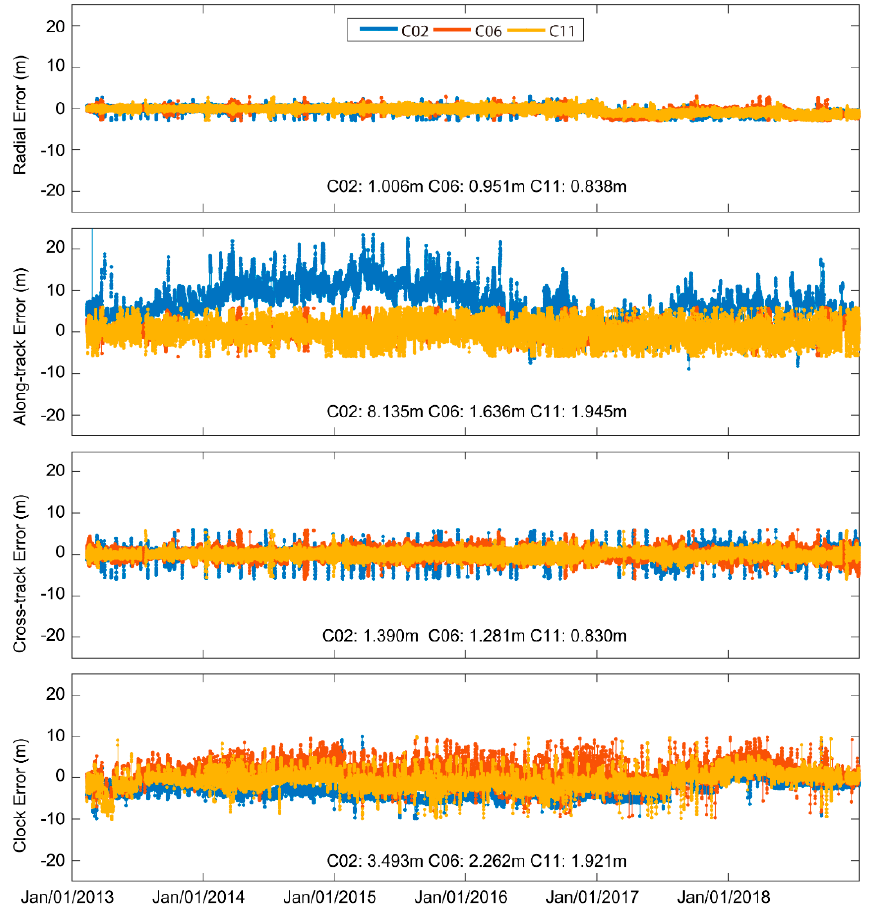
Figure 6. Six-year C02/C03/C11 broadcast navigation message orbit and clock error time series.